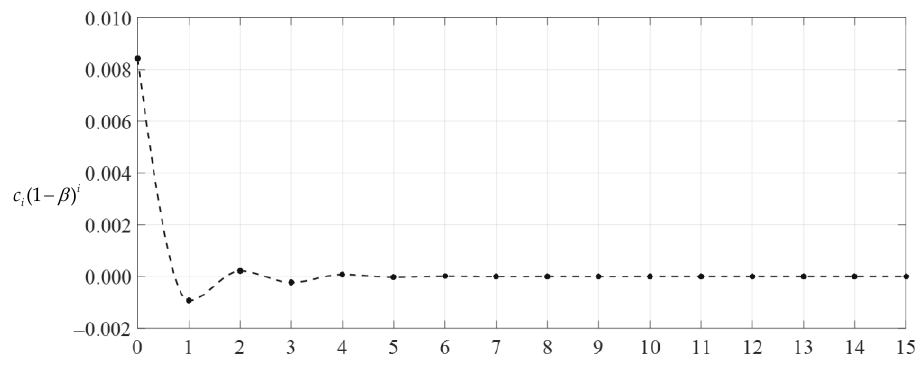
Figure 7. Variation of c i (1 − β ) i with i .